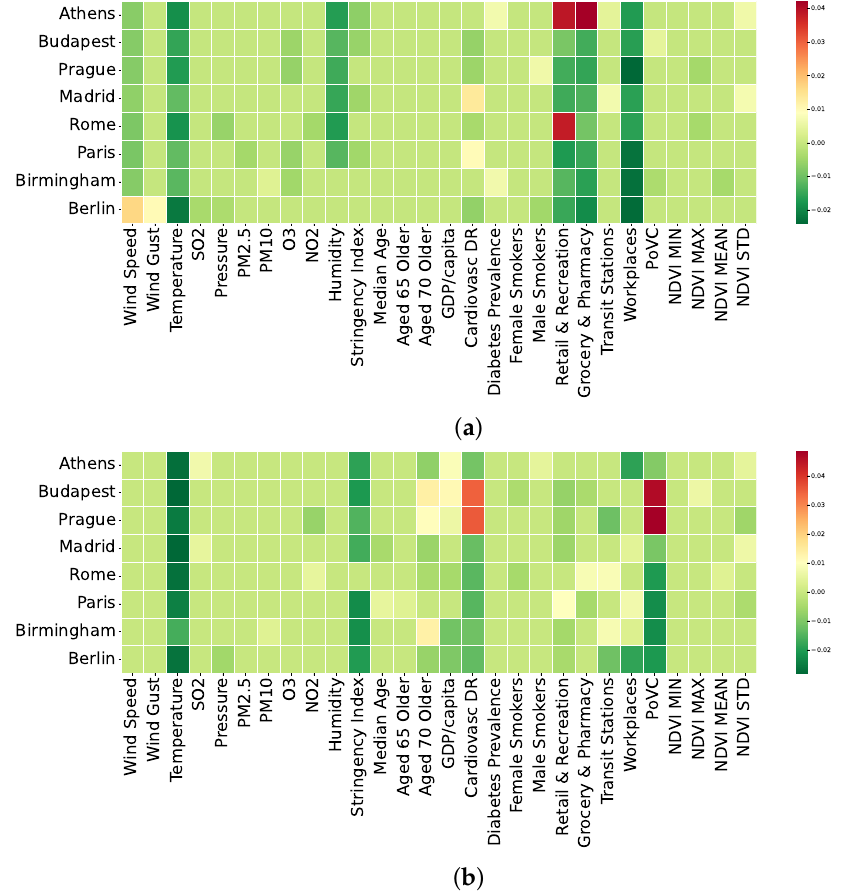
Figure 7. Local feature understanding using LIME framework. The contribution of each feature to each city is illustrated with heatmaps for 2021. Each row represents, for each city ( y -axis), the LIME calculated weights for each indicator ( x -axis). Green color suggests a negative influence on the model’s outcome, while a red one is positive. ( a ) Heatmap of LIME weights for cases model; ( b ) heatmap of LIME weights for deaths